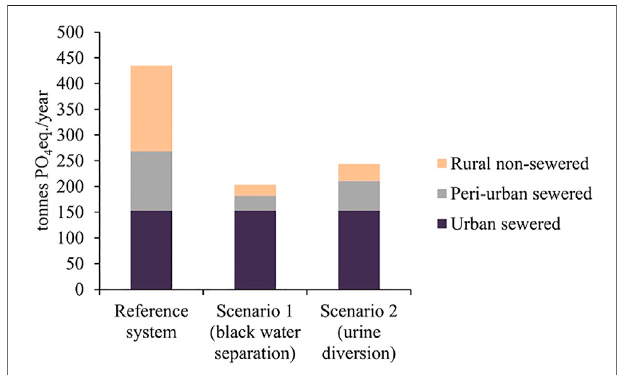
FIGURE 5 | Acidi fi cation (tonnes SO 2 eq./year) impacts of Reference System and de fi ned source separation Scenarios 1 and 2 as well as the contribution of urban, rural and peri-urban areas.